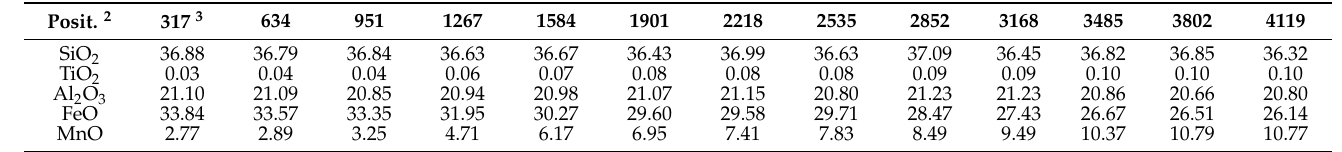
Table 5. Lu–Hf isotope data for the seven garnets and the whole rock.